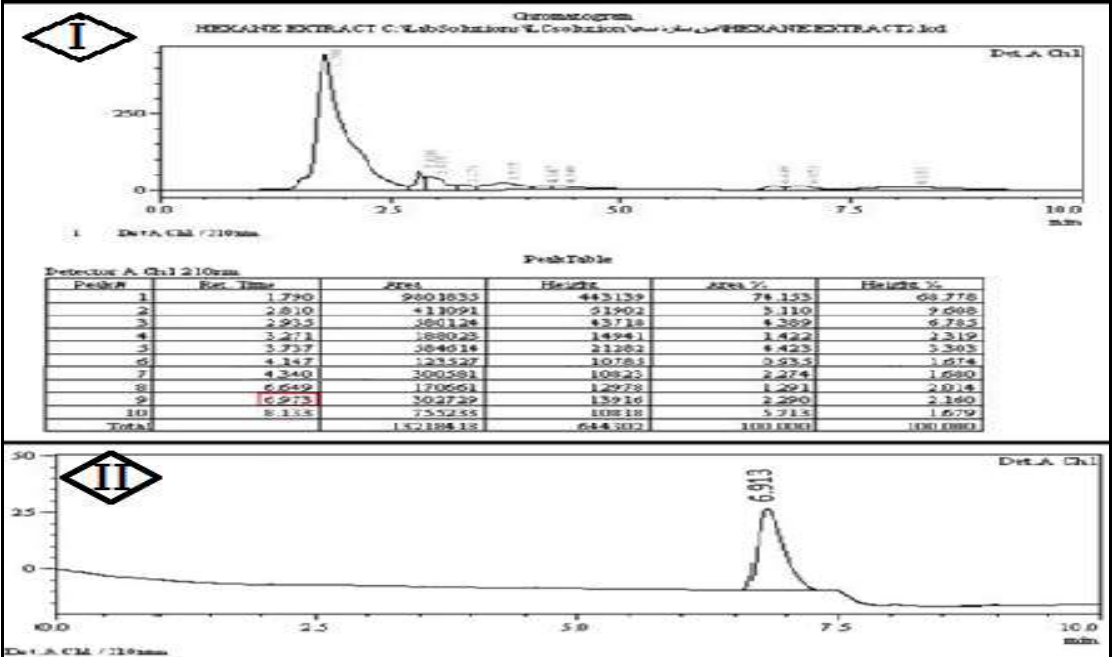
Figure2.The HPLC analysis: (I) hexane extract of Iraqi C.grandiflora flowers, (II) standard beta-sitosterol. Isolation of compound1 Hexane extract of C.grandiflora flowers was applied to PLC plates to give 52 mg (3.46 %